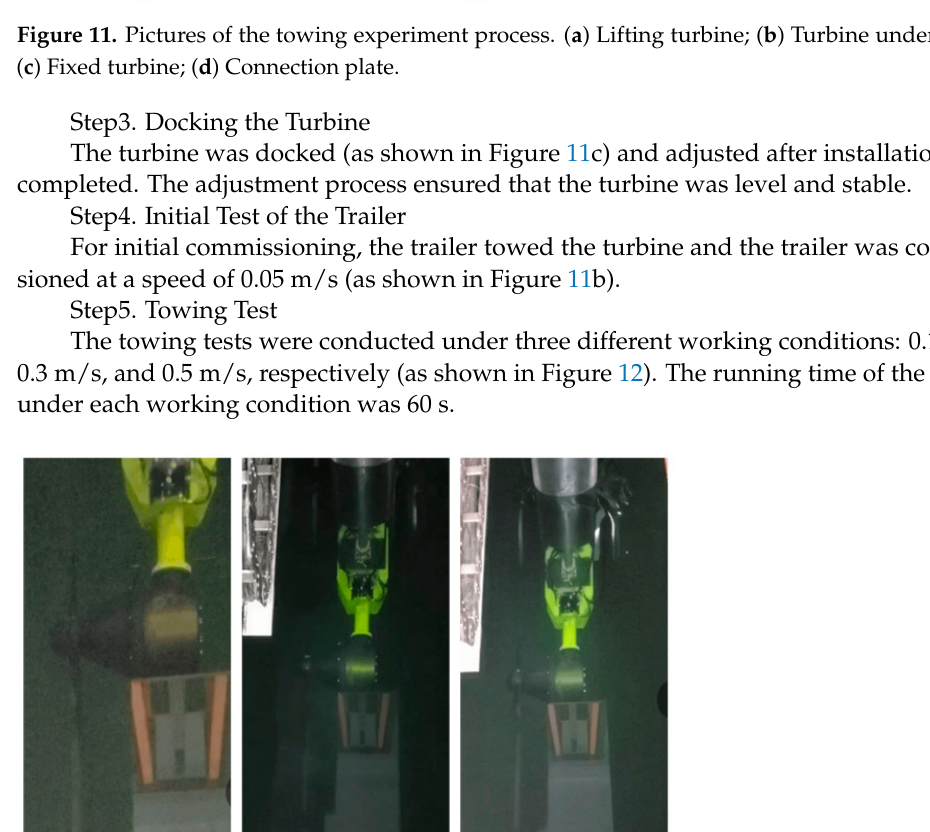
( b ) Figure 13. Experimental curve of rotational speed change. ( a ) Hydraulic pump speed change input signal, ( b ) Hydraulic motor speed output signal.